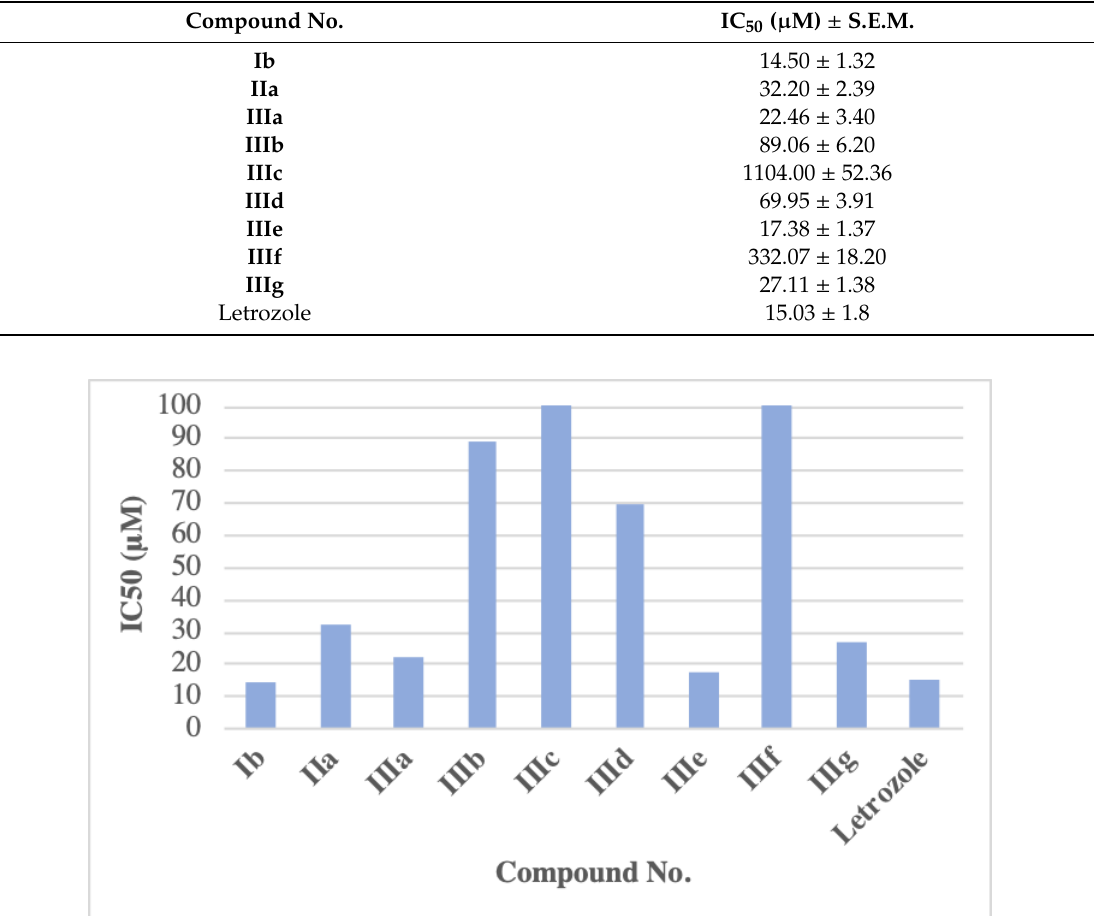
Figure 5. Aromatase inhibition activity of the tested synthesized compounds and letrozole.